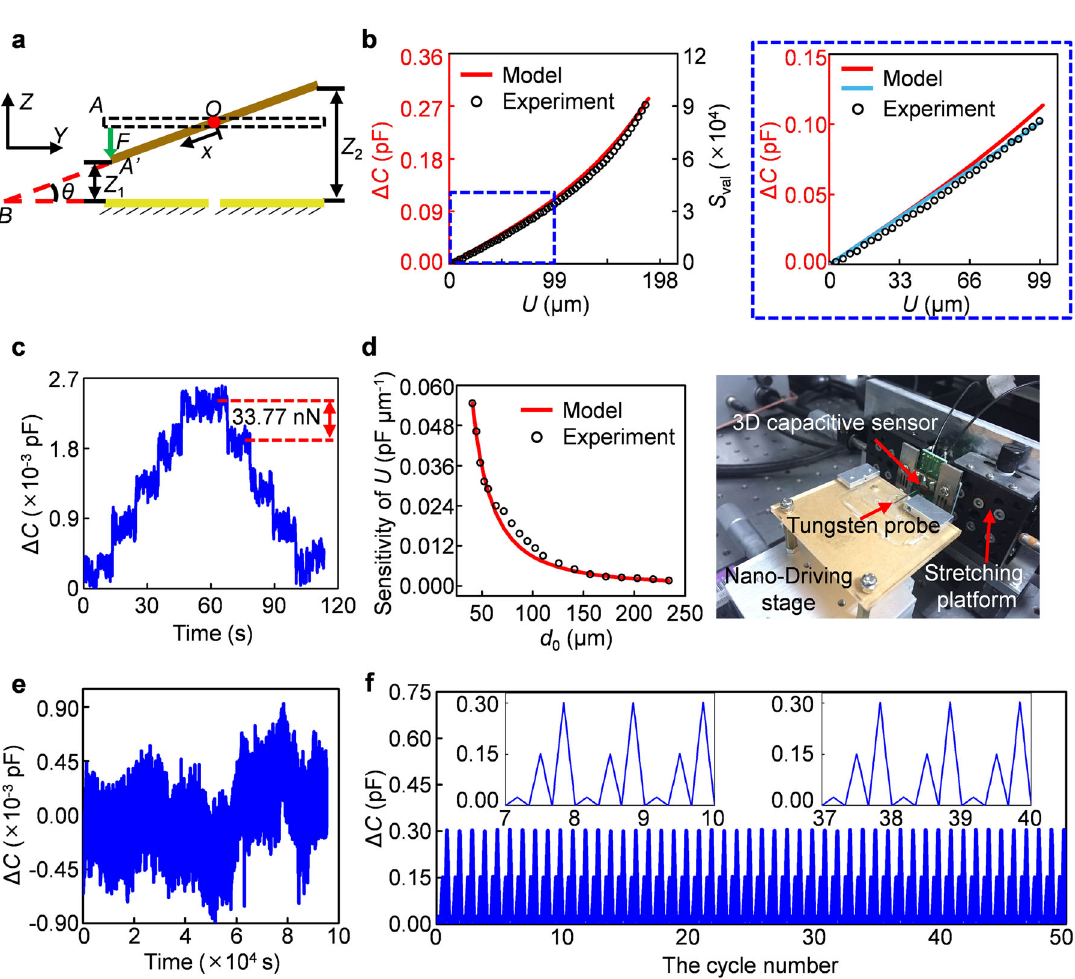
Fig. 3 Theoretical modeling and experimental measurements of the 3D capacitive sensor. a Schematic illustration of the deformation con fi guration for the 3D capacitive sensor under the out-of-plane compressive force loading. b Electrical response of a 3D capacitive sensor at different levels of compressive displacement ( U ). The right panel shows the approximate linear correlation for relatively small compressive displacements (<99 μ m). c Response of a 3D capacitive sensor under the compressive loading applied by AFM (0.05 V for each increment voltage). The incremental force of adjacent steps is 33.77 nN. d Sensitivity of Z -direction displacement as a function of the initial gap ( d 0 ). The right panel shows the measurement system. e Variation of the output signal of a sample without external loads during 100,000 s. f Cyclic testing of the 3D capacitive sensor for 50 cycles. The initial gap between the upper and lower electrodes is tuned in sequence (from ~200 to ~85 to ~54 μ m) in an adjustment